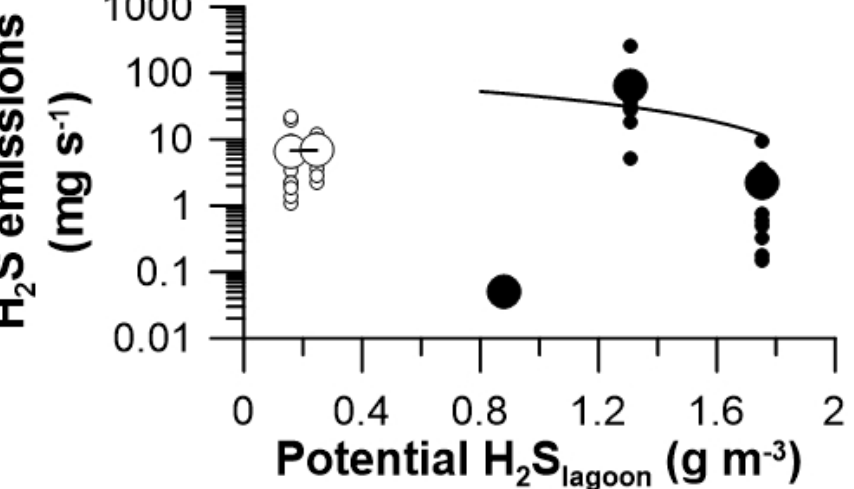
Figure 7. Relationship between potential lagoon liquid H 2 S concentration and H 2 S emissions. The daily mean half-hour emissions for the NC (filled circle) and OK (open circle) lagoons are indicated relative to lagoon S concentration for ± five days of lagoon liquid concentration measurement. Large symbols indicate mean emissions for a given H 2 S concentration.